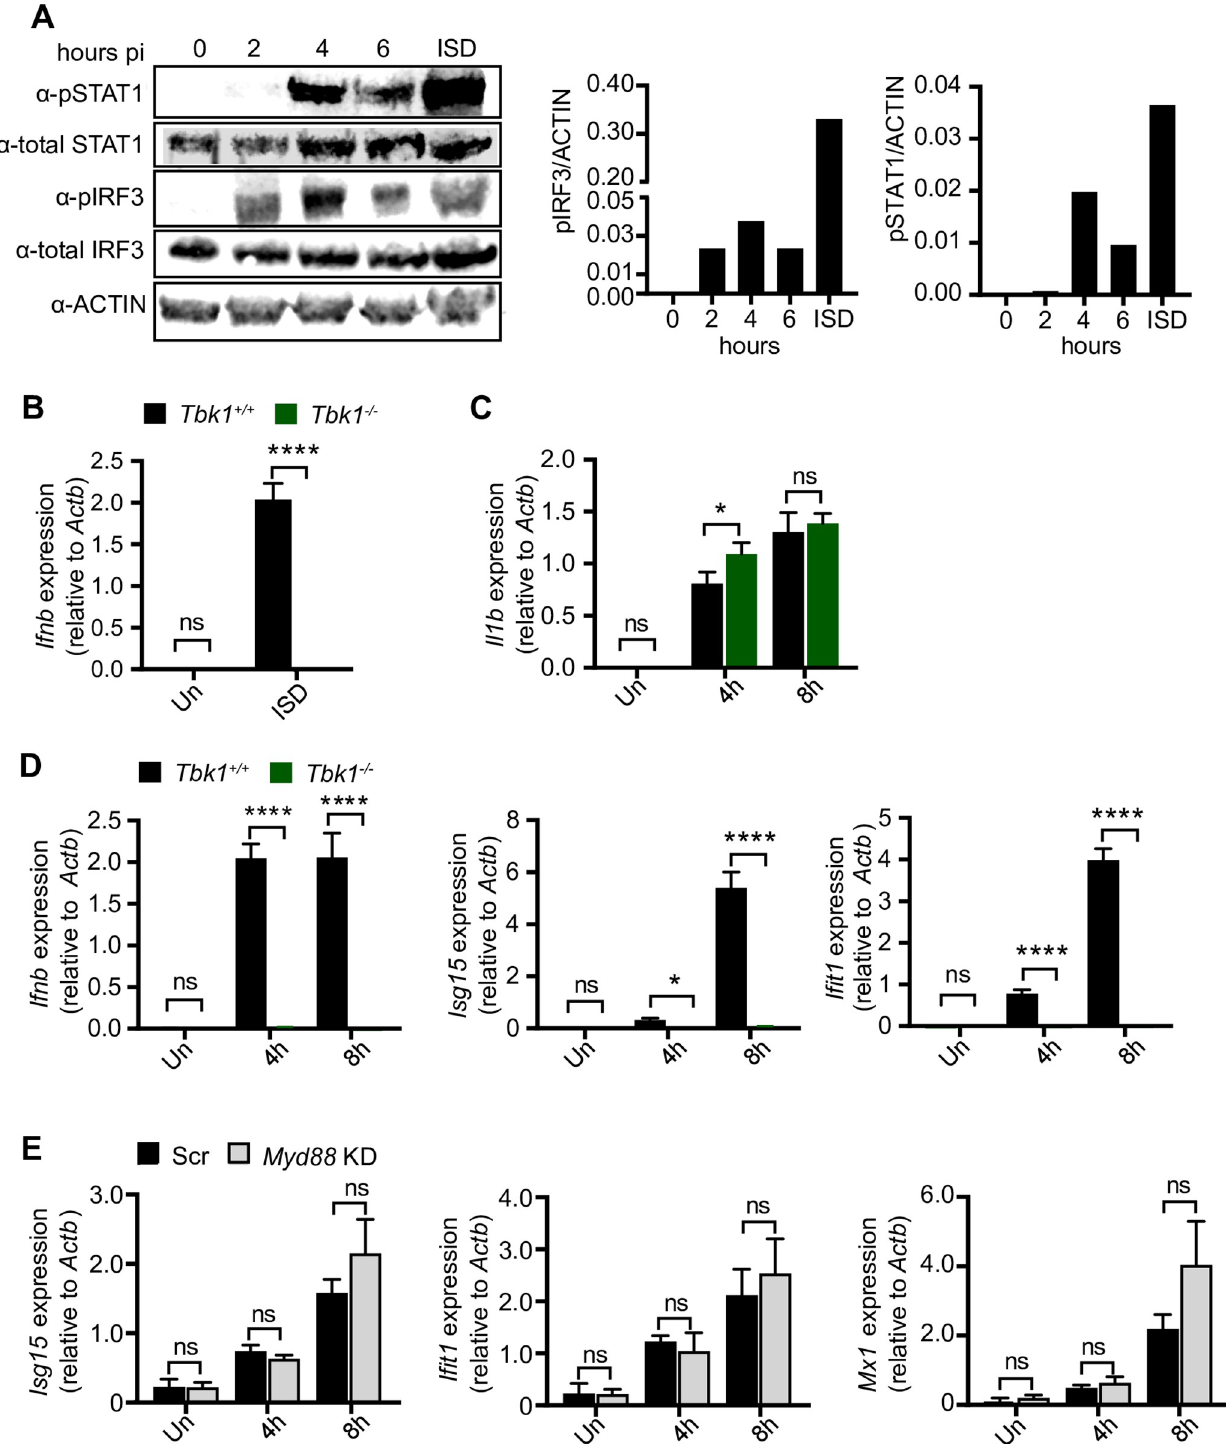
Fig 4. TBK1 is required for type I IFN induction in response to R . equi infection in primary murine macrophages. (A) Immunoblot of pSTAT1, total STAT1, pIRF3 and total IRF3 in RAW 264.7 macrophages infected or not (0) with R . equi for 2, 4 or 6h or transfected with ISD for 4h. ACTIN was used as a loading control. (B) RT-qPCR of Ifnb in control ( Tbk1 +/+ Tnfr -/- ) and KO ( Tbk1 -/- Tnfr -/- ) BMDMs transfected with ISD for 4h. (C) RT-qPCR of Il1b in TBK1 BMDMs uninfected or infected with R . equi for the indicated times. (D) As in (C) but Ifnb , Isg15 and Ifit1 . (E) RT-qPCR of Isg15 , Ifit1 and Mx1 in Myd88 KD macrophages infected with R . equi for the indicated times. All RT-qPCRs are representative of at least 2 independent experiments and are the